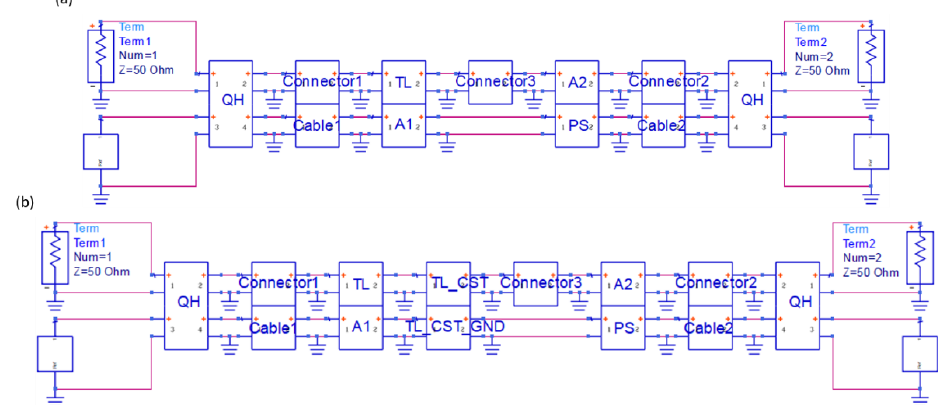
Figure 4. The modeling of the interferometric cytometry system in ADS ( a ) without sensor simulation in CST; and ( b ) with sensor simulation in CST. QH stands for quadrature hybrid, the 90-degree coupler; TL stands for transmission line, which is the tapered CPW sensor; A1 is the 6 dB attenuator; A2 and PS are the tunable attenuator and phase shifter respectively.